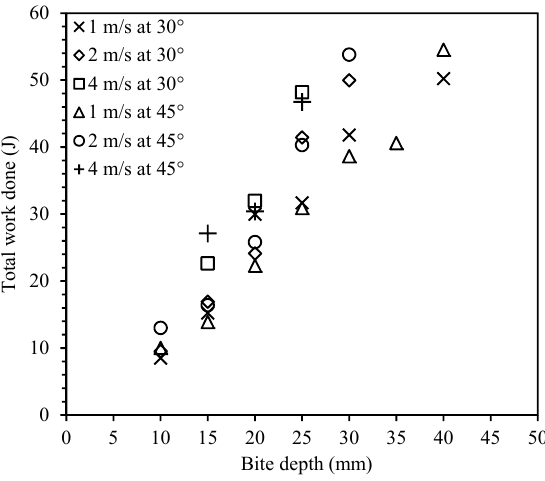
Fig. 8 Energy absorbed against bite